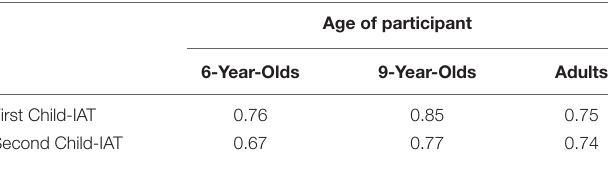
TABLE 1 | Estimates of internal consistency (coefficient alpha) by age of participant and order completed (Study 2).